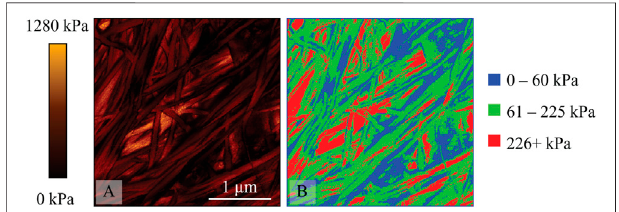
FIGURE 4 | A non-cross-linked collagen sample prepared from 8.56 mg/mlsolution (A) 3 μ m×3 μ meffectivemodulusmapfromQIdatawith fi xed range of 0 – 1280 kPa (B) 3 μ m × 3 μ m RGB image where blue represents 0 – 60 kPa regions, green 61 – 225 kPa regions, and red 226+ kPa